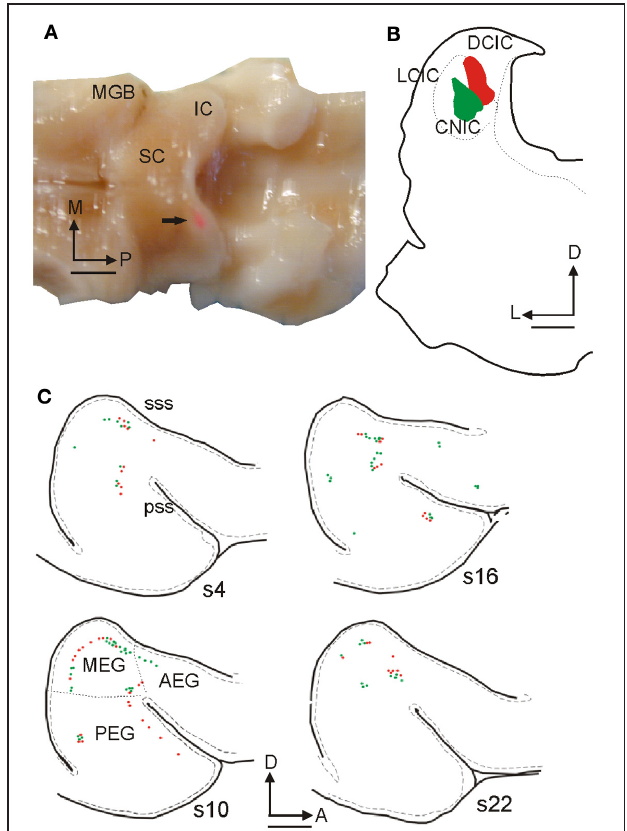
FIGURE 3 | Retrogradely labeled cells in ferret auditory cortex after fluorescent microbead injections in the IC. (A) Dorsal view of the ferret brain where both the cerebral cortices and the cerebellum were removed to visualize the thalamus and midbrain. A rhodamine microbead injection site can be seen in the left IC (arrow). (B) Coronal section at the level of the IC from this animal illustrating rhodamine and fluorescein microbead injection sites. (C) Drawings of tangential 50 µ m sections spaced 300 µ m apart from lateral to medial (s22 is the most medial) at the level of the left ectosylvian gyrus where the auditory cortex is located, showing green and red retrogradely labeled cells. Calibration bars: 2mm (A,C) and 1mm (B) . Based on Bajo et al.